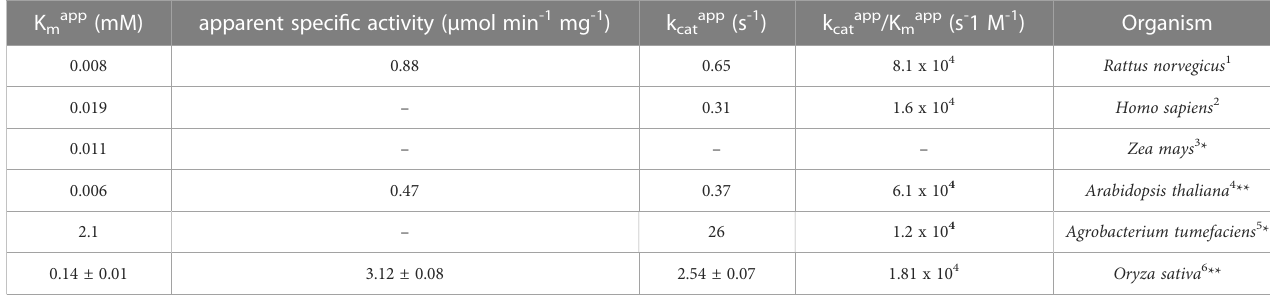
TABLE 4 Apparent kinetic parameters of ß-ureidopropionases from different organisms with the substrate ß-ureidopropionic acid. K mapp